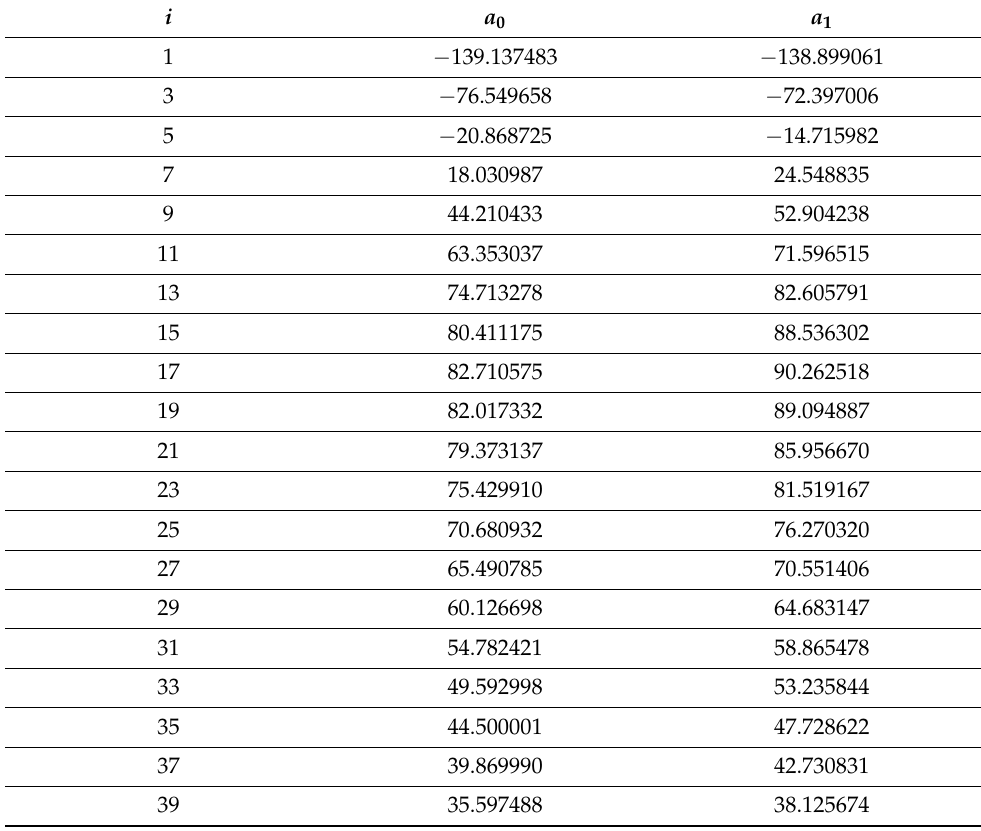
Table 3. Parameters for Equation